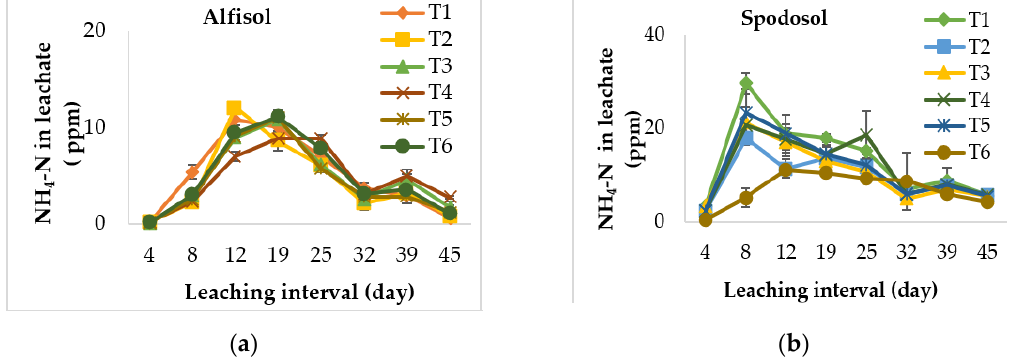
Figure 2. Effects of treatments on NH 4 ‐ N leaching at different leaching intervals from ( a ) Alfisol soil and ( b ) Spodosol soil.